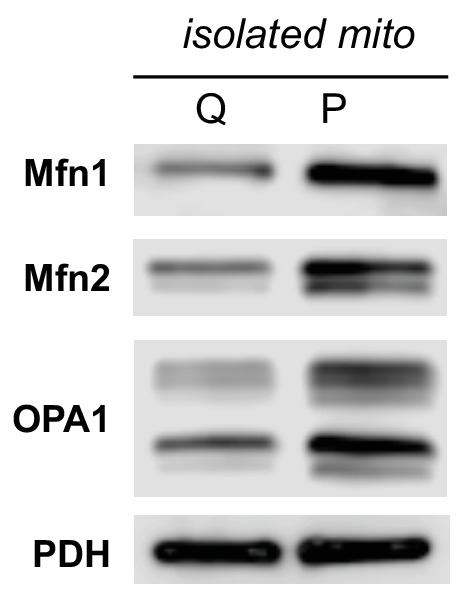
Mitochondria in proliferating fibroblasts have increased levels of mitochondrial fusion proteins compared to quiescent fibroblasts.Isolated mitochondrial lysates were immunoblotted for Mfn1, Mfn2, and OPA1. Pyruvate dehydrogenase (PDH) was used as a mitochondrial matrix loading control.